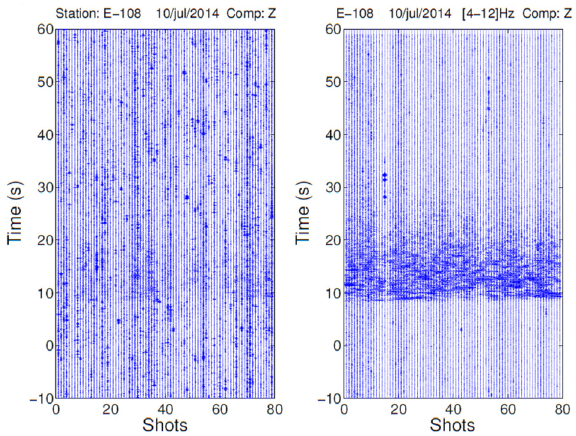
Figure 7. Comparison of a series of shots before filtering (left panel) and after filtering (right